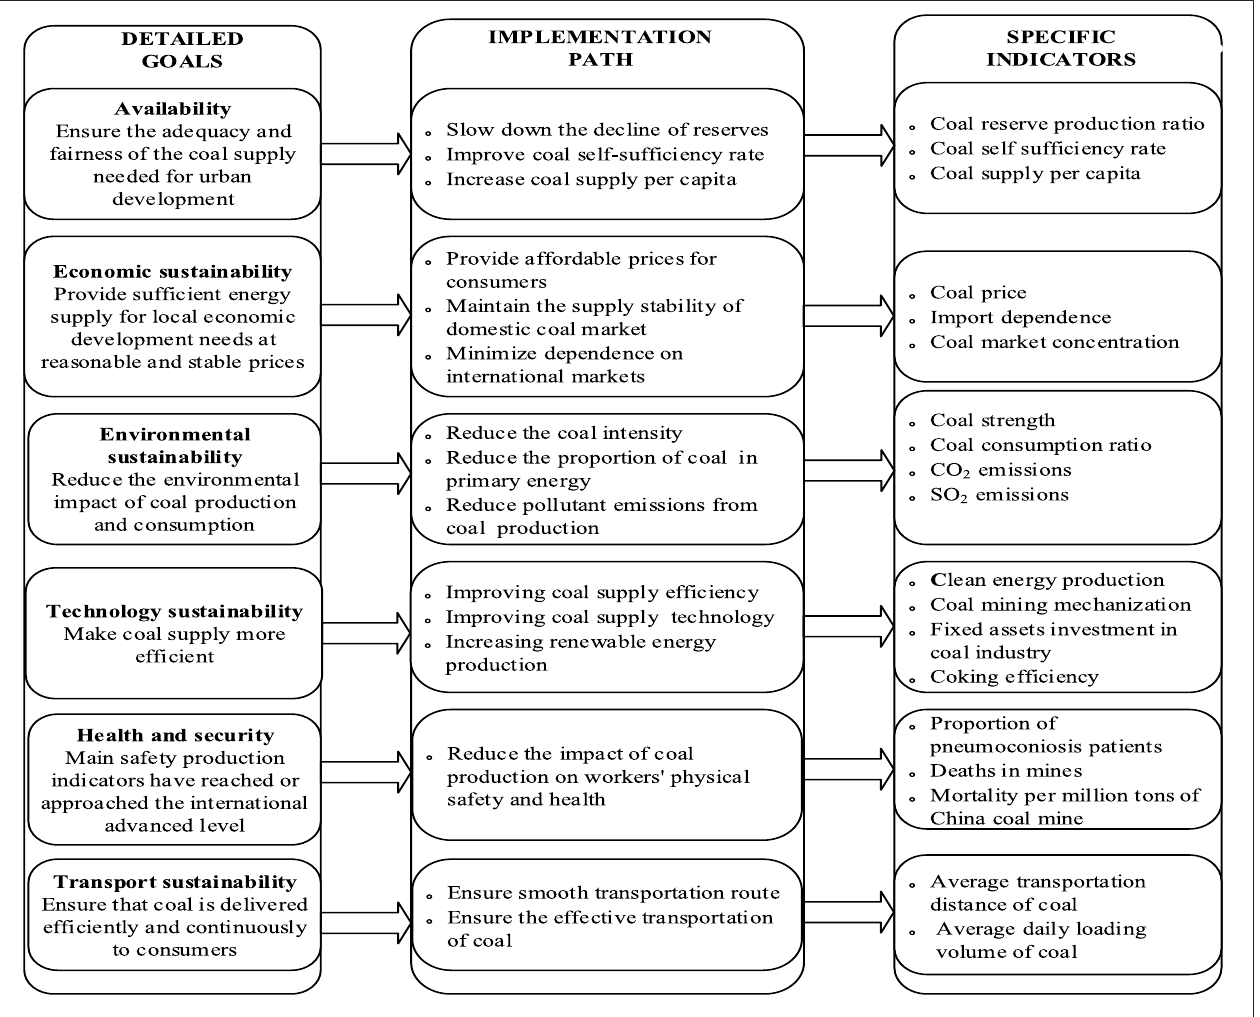
FIGURE 2 | Summary of China ’ s coal supply sustainable goals and quanti fi cation measurements.